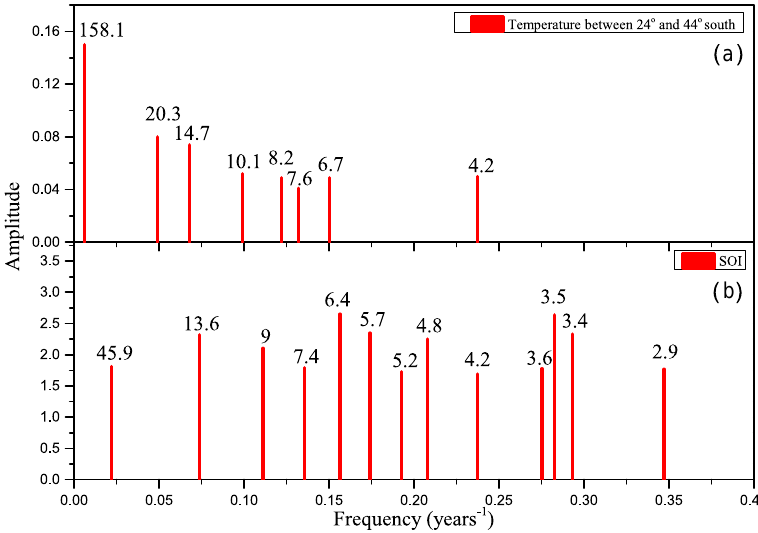
Figure 5. Amplitude spectra of the (a) annual mean temperature anomaly between 24 and 44 ◦ S; (b) SOI. The significance level is 95%.